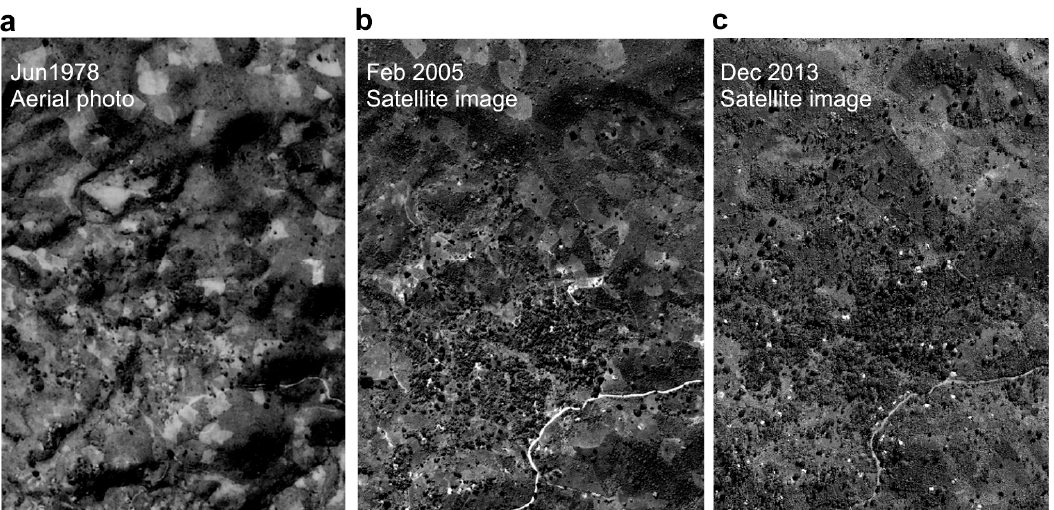
Figure 4. Effects of the Ujamaa policy on the development of forest-like landscape in the study village. Comparison of aerial photographs obtained in 1978 (National Information purchased from Office for Dar es Salaam) and satellite images obtained in 2005 and 2013 (purchased from Pasco Corporation; Quick bird pan-sharpened image). The dotted boxed portion indicates the satellite images and the aerial extent of the image shown in Figure 4.